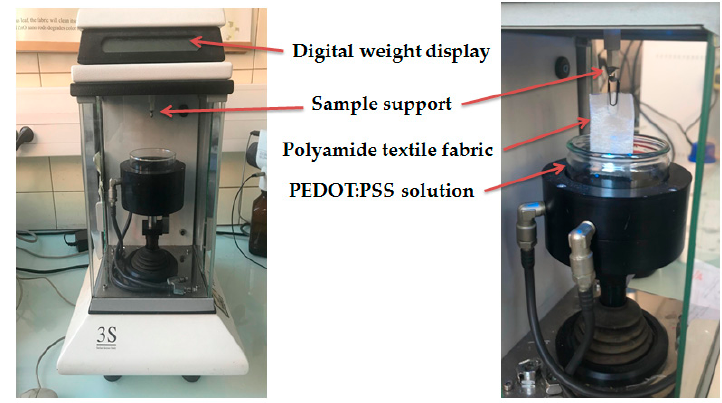
Figure 2. Contact angle measurement with 3S instrument.